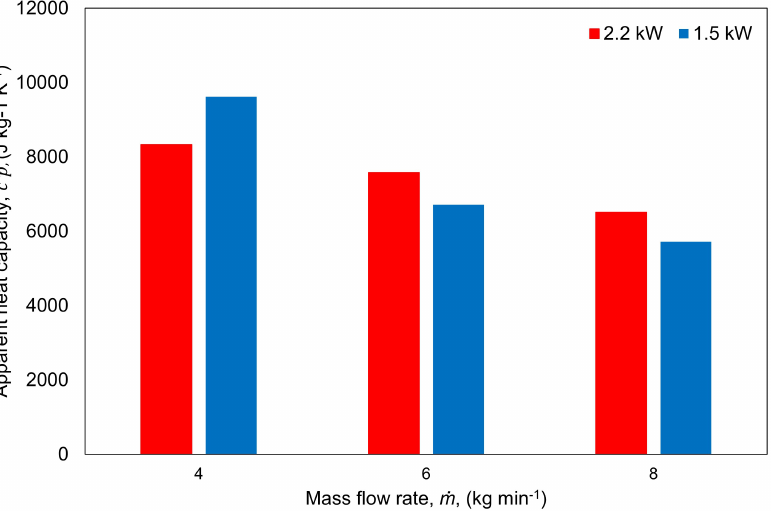
Figure 6. The calculated apparent heat capacities of the PCD at the three different mass flow rates (4, 6 and 8 kg min − 1 ) and the two heating inputs (2.2 and 1.5